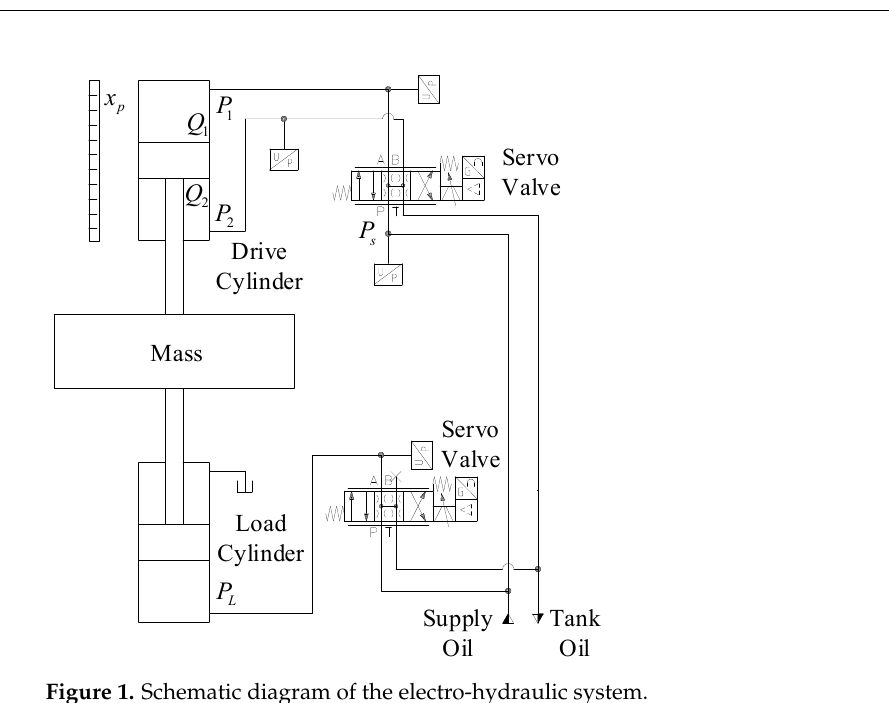
Figure 1. Schematic diagram of the electro-hydraulic system.